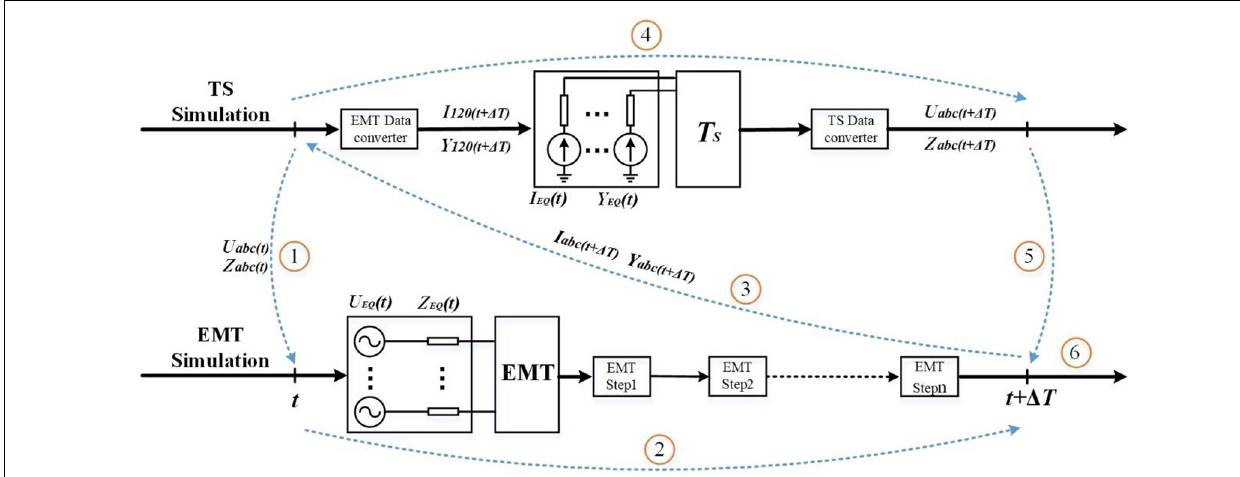
FIGURE 4 | Interaction process of the hybrid simulation.